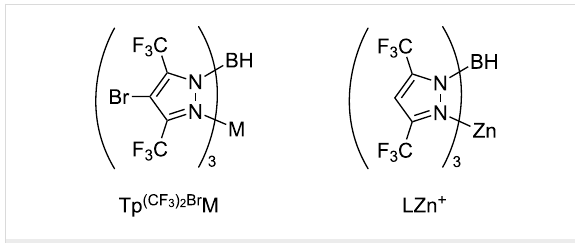
Figure 2: Structure of TpM-type